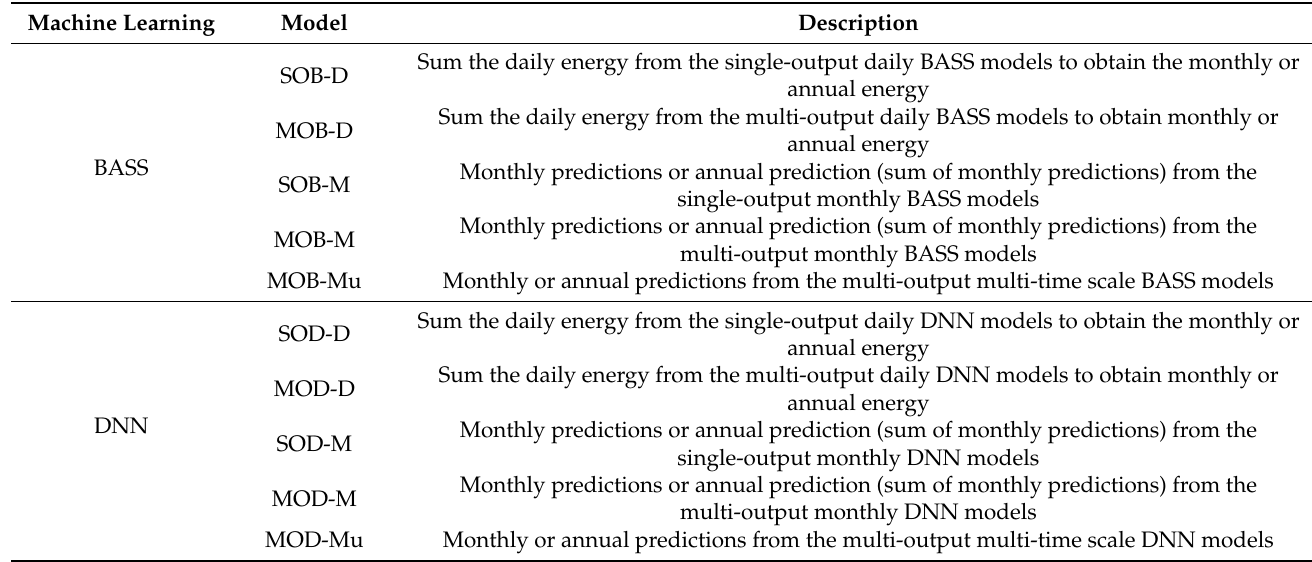
Table 4. Description of 10 models for monthly or annual energy